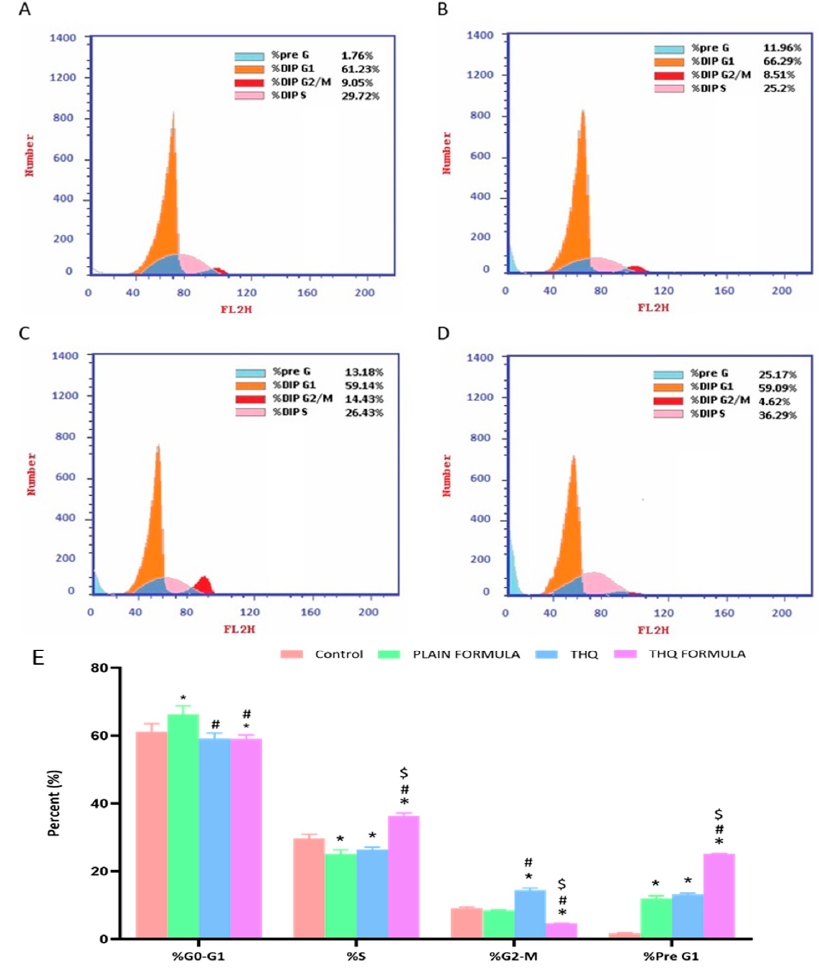
Figure 5. Flow cytometric analysis of control ( A ), plain formula ( B ), THQ ( C ), and THQ formula ( D ) treated cells and the percentages of cells in the G1, S, and G2/M phases of the cell cycle ( E ). * Significantly different from control at p < 0.05, # significantly different from plain formula at p < 0.05. $ Significantly different from THQ at p < 0.05.